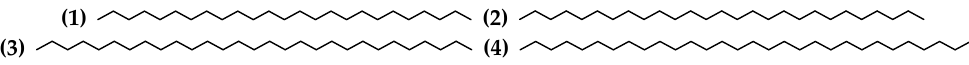
Figure 7. Structure of the hydrocarbons from Brugmansia suaveolens.